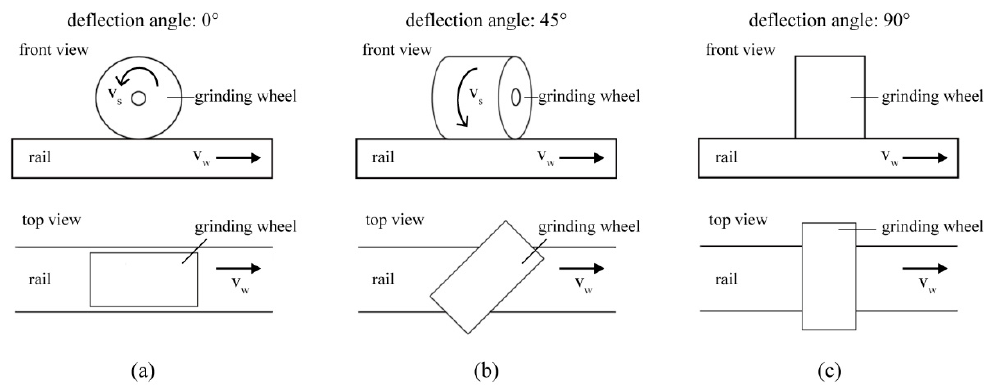
Figure 7. Passive grinding process under different deflection angles, ( a ) 0°, ( b ) 45°, ( c ) 90°.